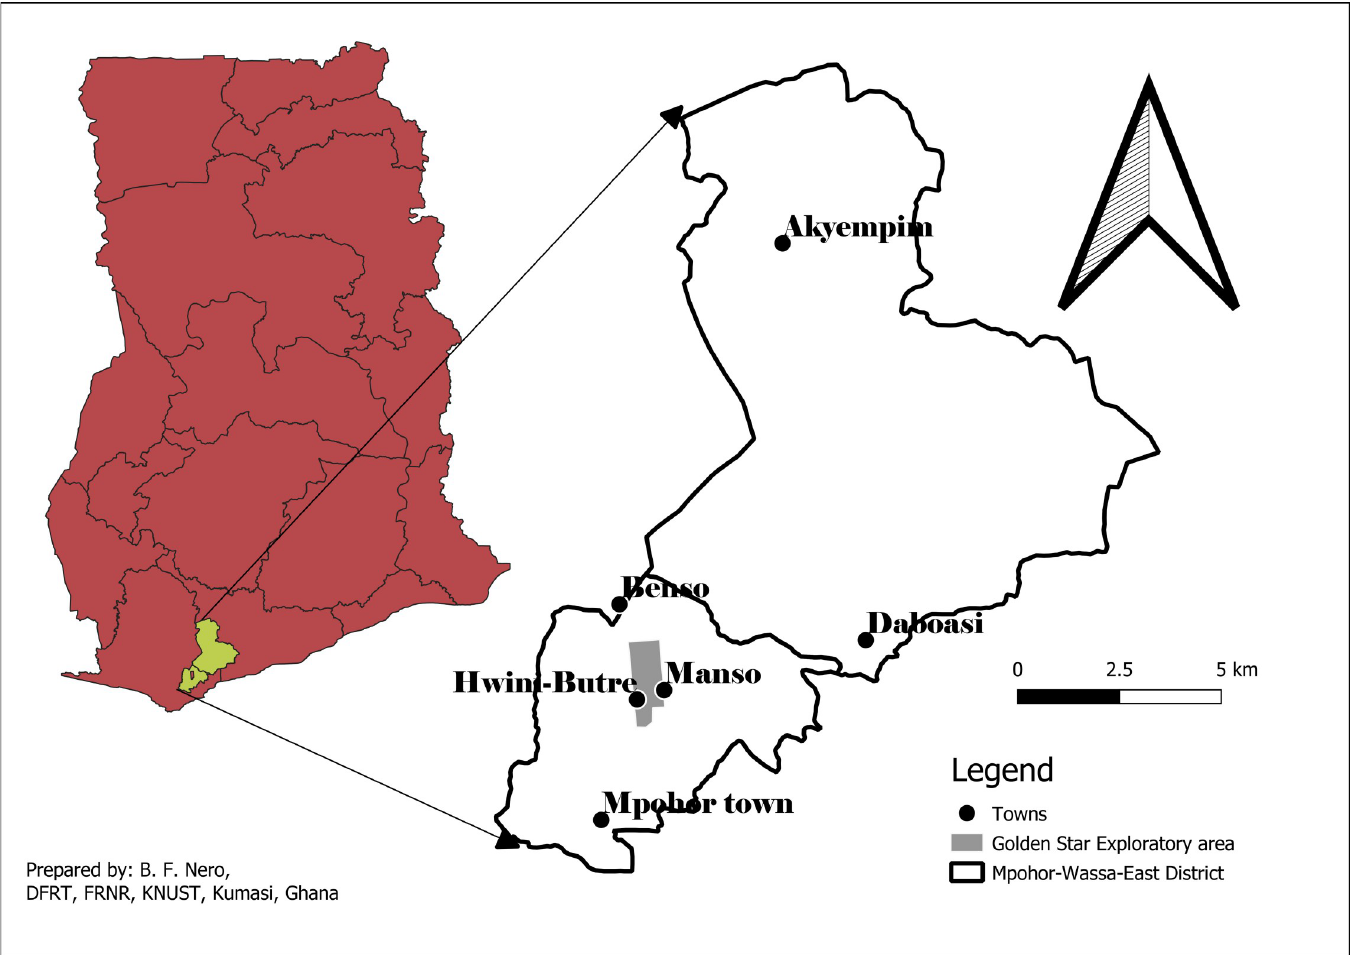
Fig 1. Map of Mpohor Wassa East district of Ghana showing the Hwini-Butre/Benso Golden Star exploratory area where the study was conducted.